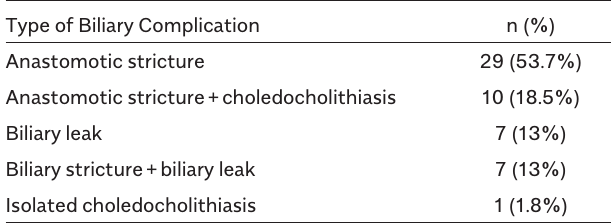
Table 1. The Rate and Type of Biliary Complications After LT Type of Biliary Complication